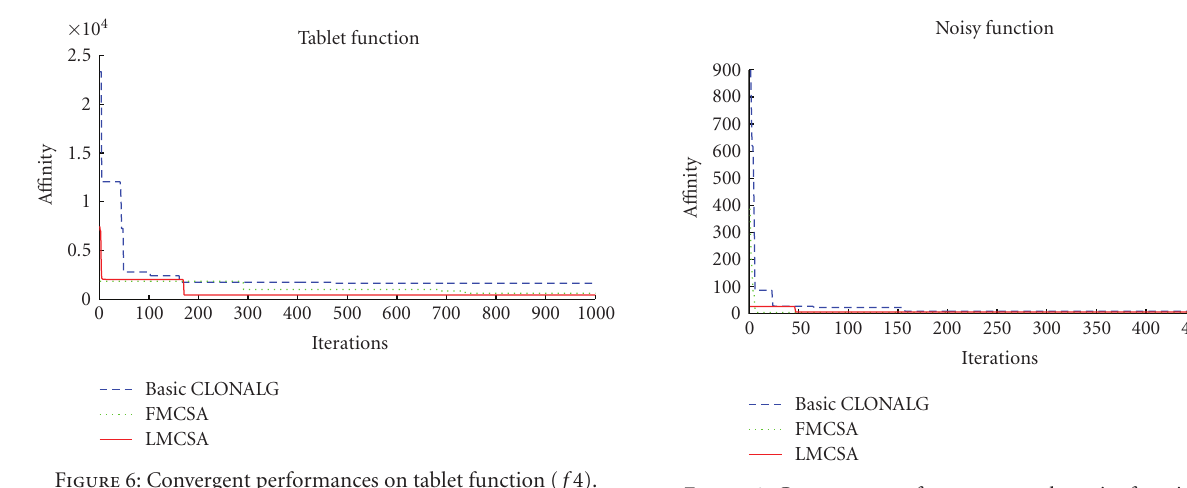
Figure 9: Convergent performances on the noisy function ( f 7).